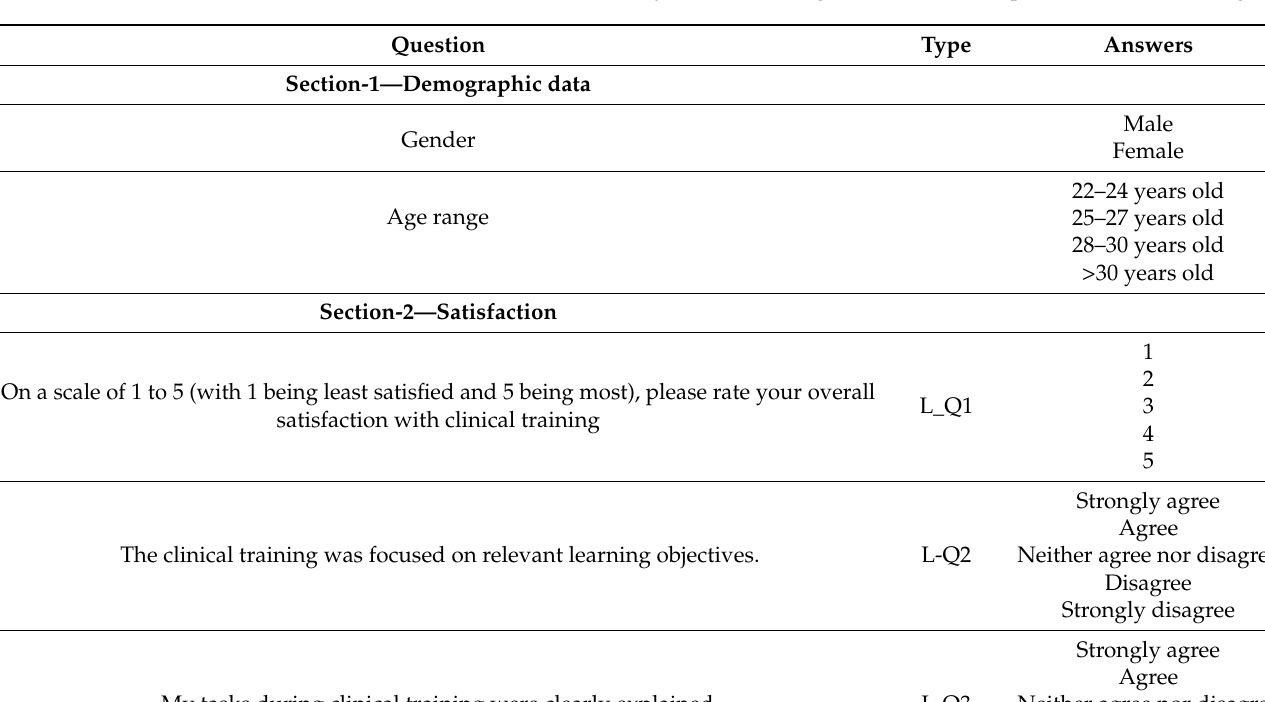
Table A1. Sample of the survey questionnaire of students’ feedback on clinical training given both at the end of the traditional veterinary clinical training and of the virtual problem-based